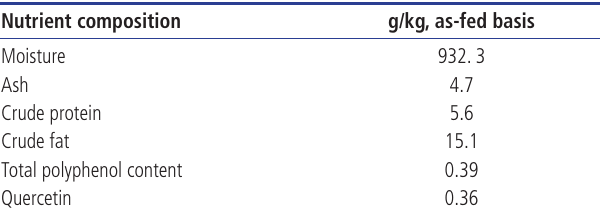
Table 2. Nutrient composition, total polyphenol and quercetin concentration of experimental onion extract Nutrient composition